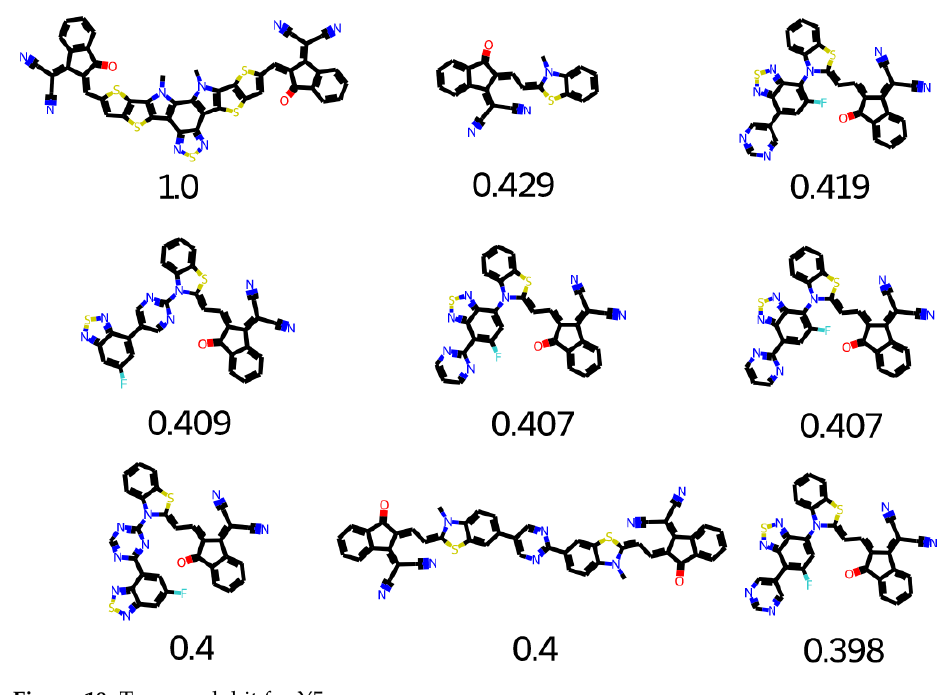
Figure 19. Top search hit for Y5.